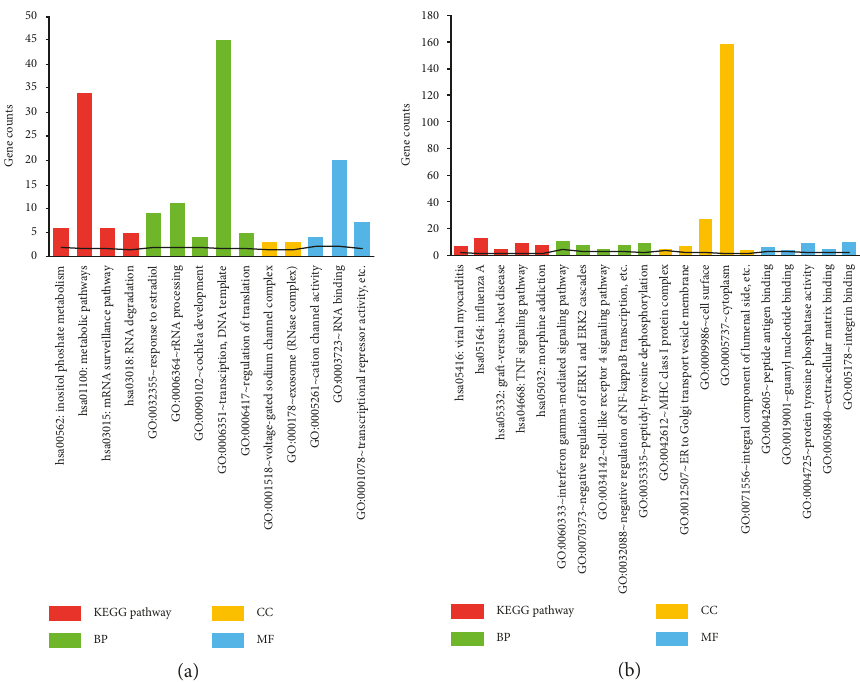
Figure 2: Functional enrichment analyses of differentially expressed genes (DEGs). (a) Gene Ontology (GO) terms and the Kyoto En- cyclopedia of Genes and Genomes (KEGG) pathways of upregulated DEGs and (b) GO terms and KEGG pathways of downregulated DEGs. The numbers on the x -axis were the ID of pathways or GO terms. The numbers on the y -axis were gene